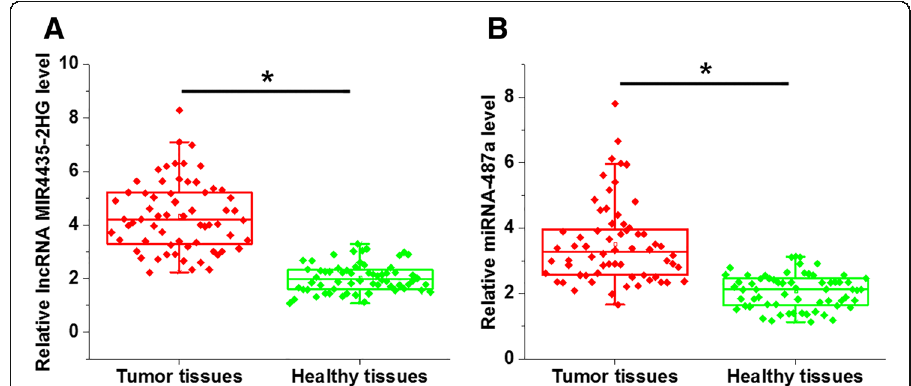
MIR4435-2HG and miRNA-487a levels were positively correlated in both tumor tissues and adjacent healthy